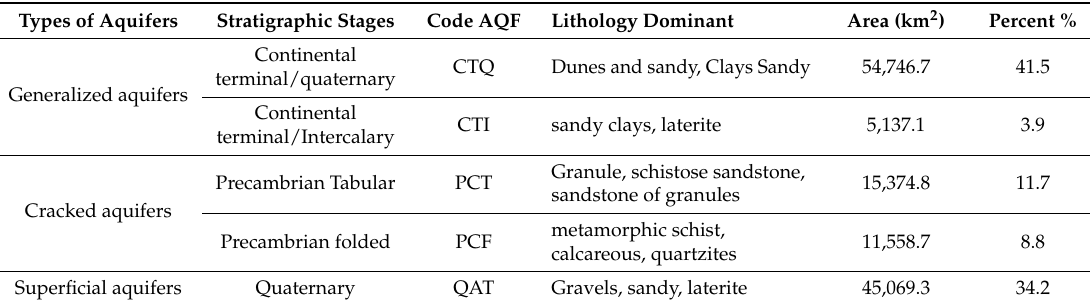
Table 2. Hydrogeological subdivisions of the